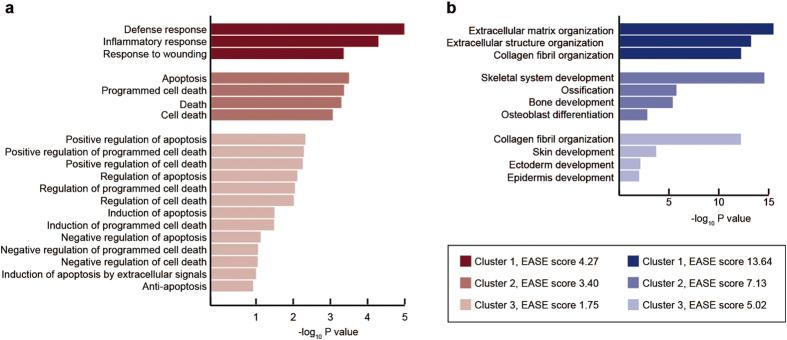
Gene ontology (GO) categories enriched among the genes up- and down-regulated in association with periodontitis.Biological processes that are up- or down-regulated in connection with periodontitis were identified using the annotation tool DAVID and related processes clustered using the functional annotation clustering tool. (a) The up-regulated processes with the highest enrichment (EASE) scores included items related to defense, inflammation and wounding responses as well as apoptosis and cell death. (b) The down-regulated gene clusters with the highest enrichment scores were related to organization of the extracellular matrix and structure, organization of collagen fibrils, as well as development of the skeleton, skin, ectoderm and epidermis.